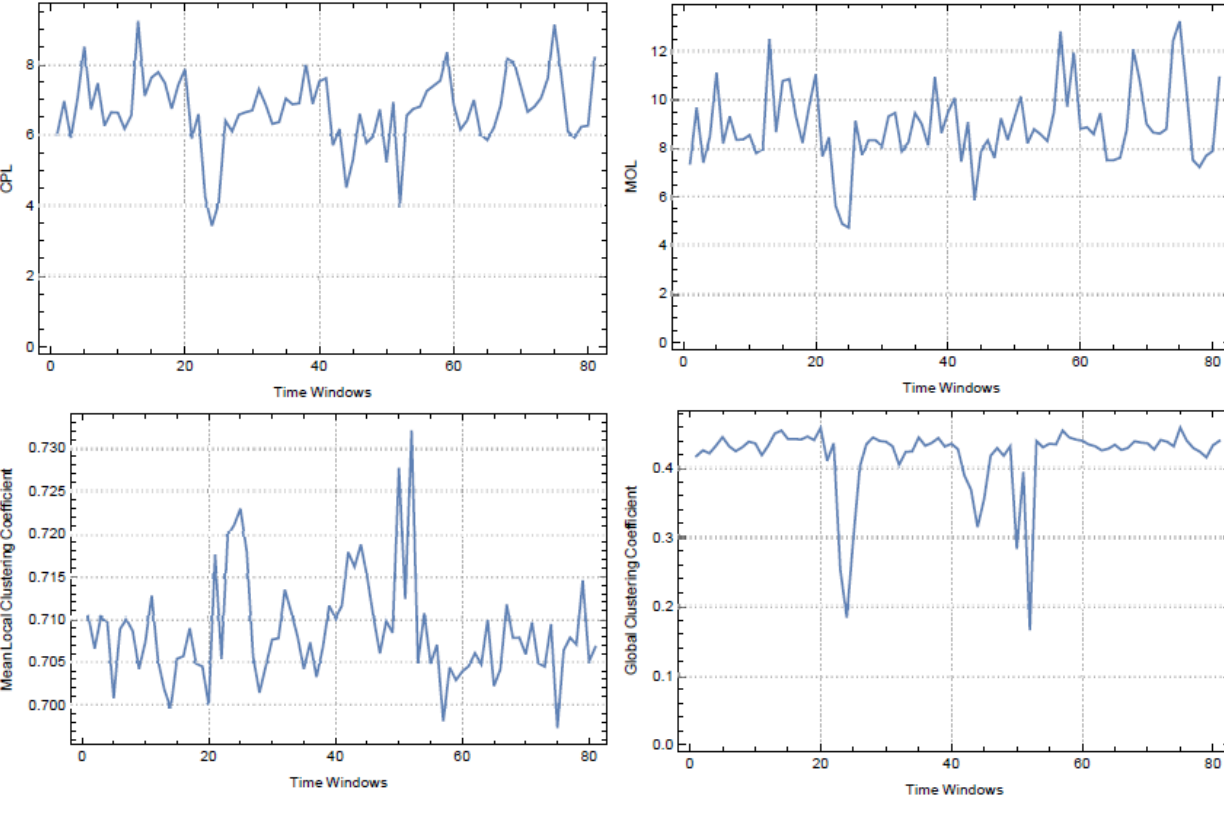
Figure 6. 𝒬 (cid:3037) measures and sizes of coarse graining of 𝐺 (cid:3021)(cid:3037) for BIST. In Figure 7, we displayed the mean values of the total Haantjes curvatures of coarse grains.